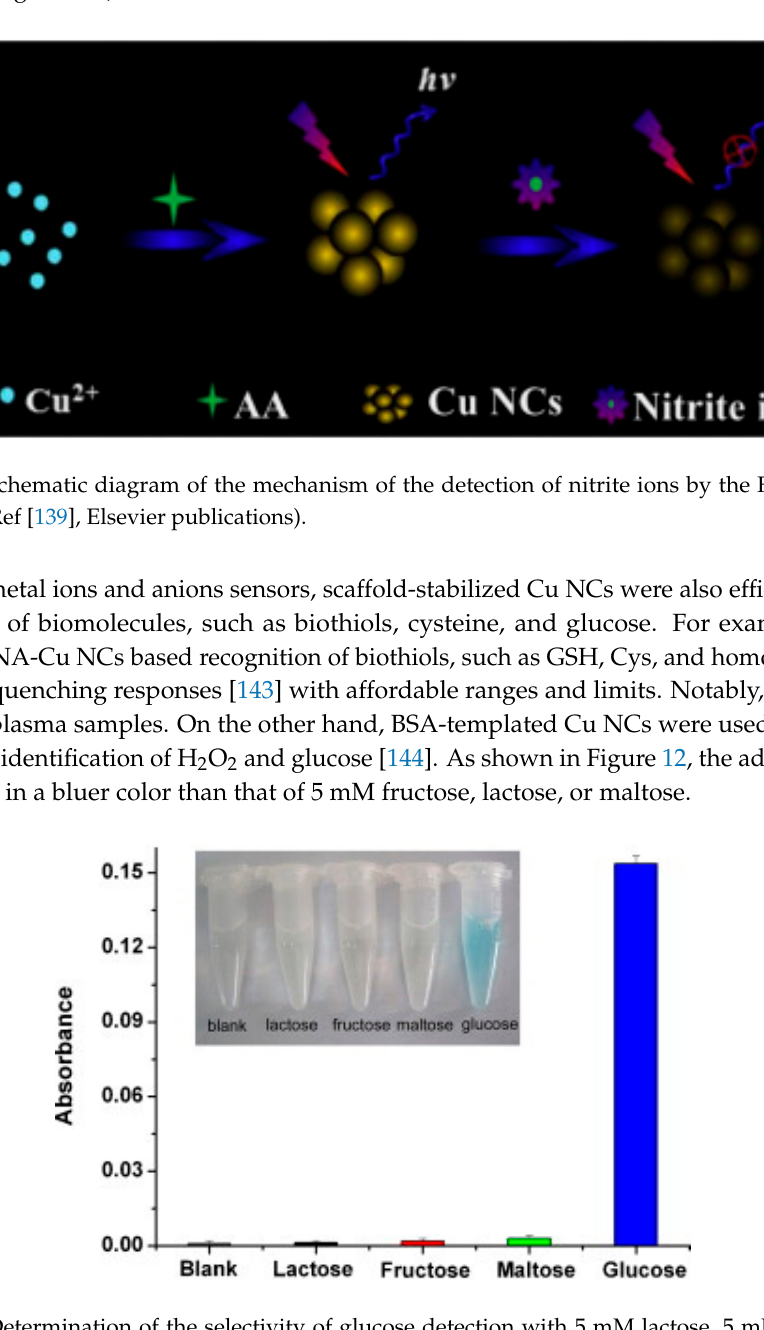
Figure 12. Determination of the selectivity of glucose detection with 5 mM lactose, 5 mM fructose, 5 mM maltose, and 2 mM glucose. The error bars represent the standard deviation of three measurements. Inset: the color change with the different solutions (Copyright Ref [144], ELSEVIER publications).